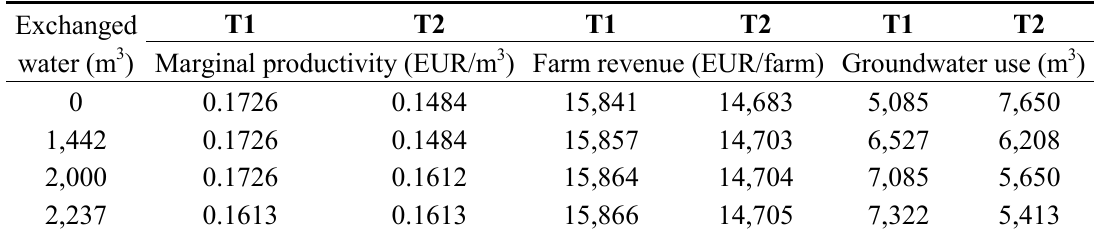
Table 5. Farms’ performances under the intra-sector market